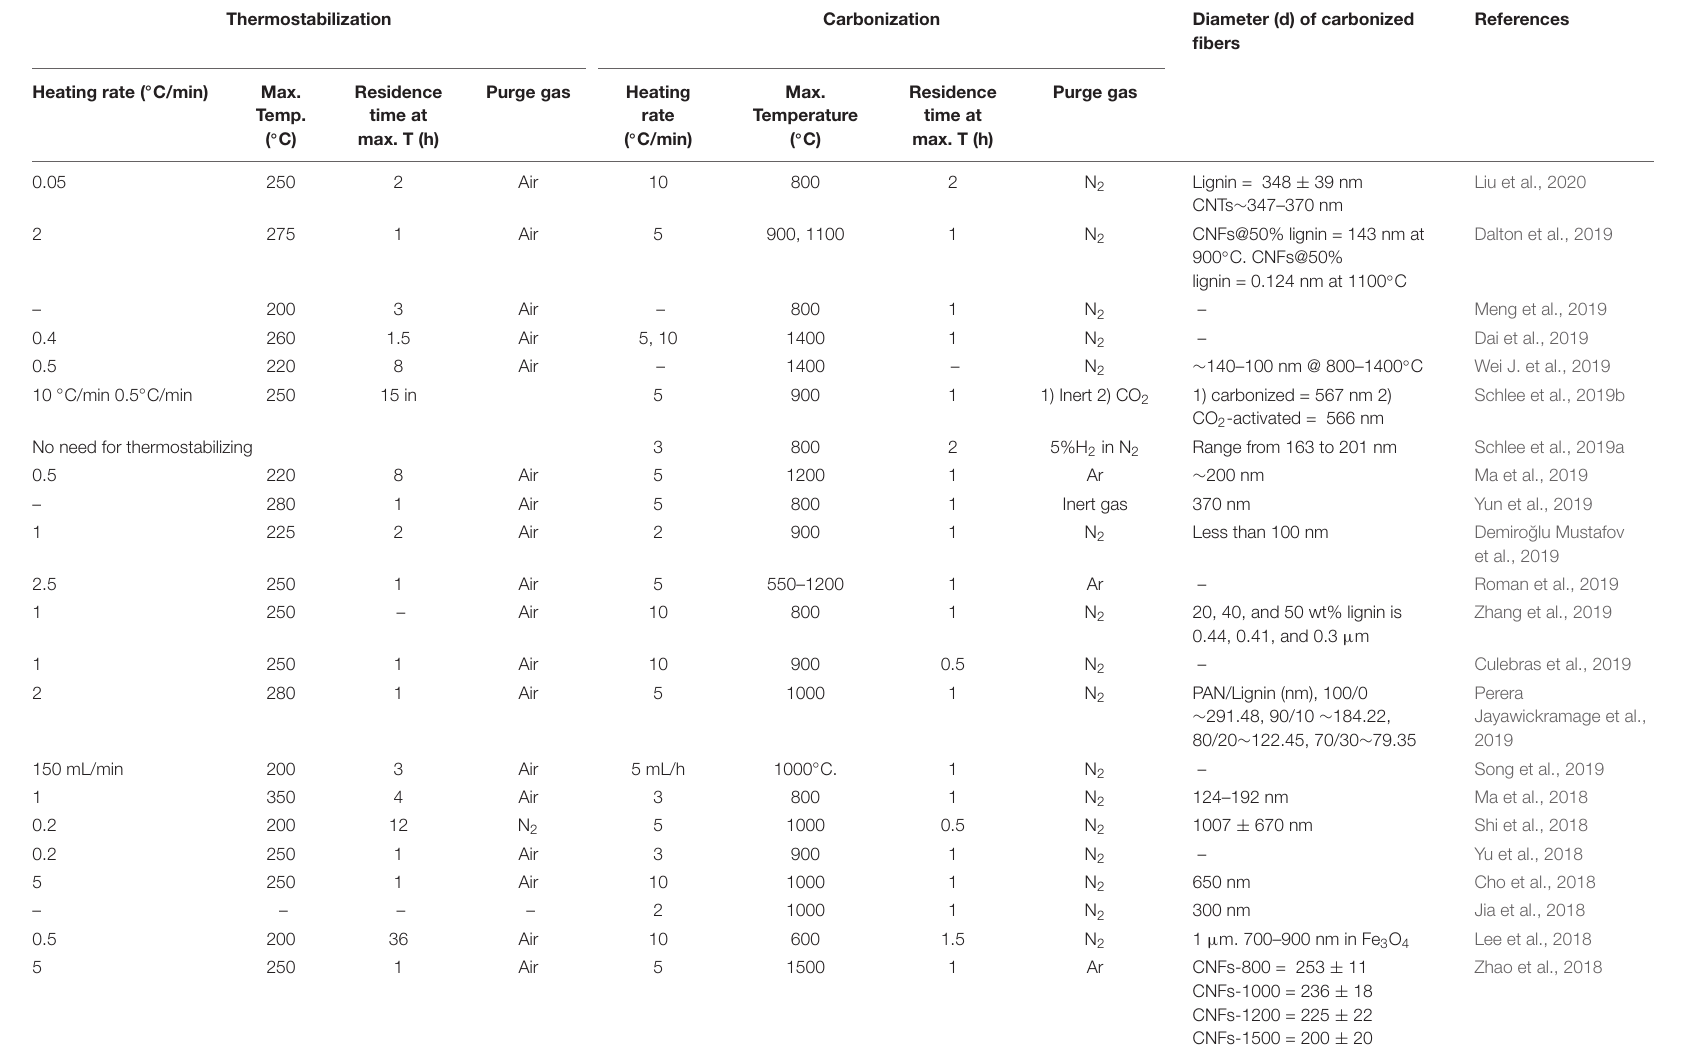
TABLE 2 | Conditions applied to produce carbonized electrospun lignin